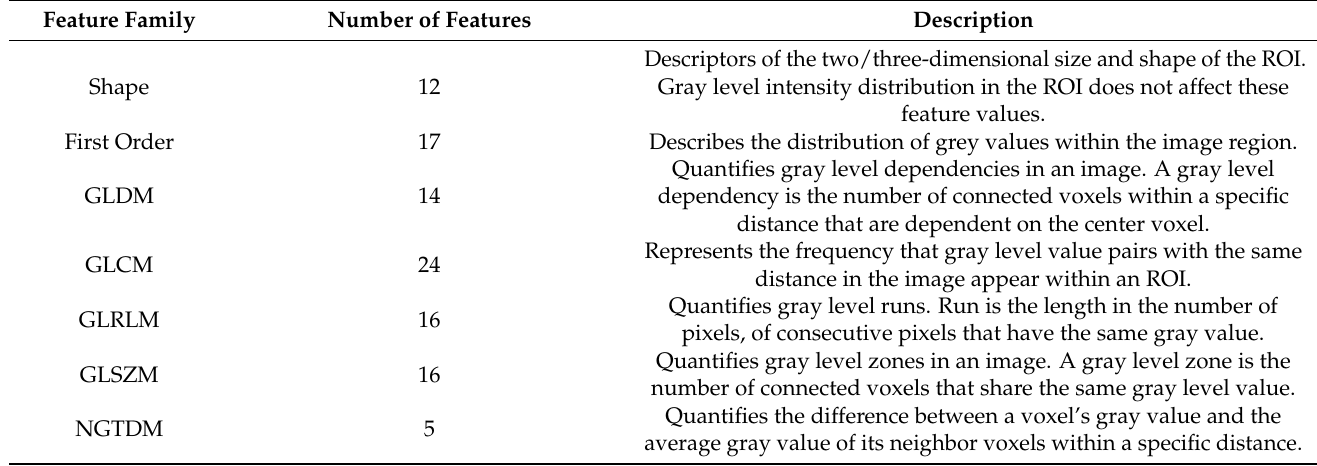
Table 1. Delta Radiomics Feature